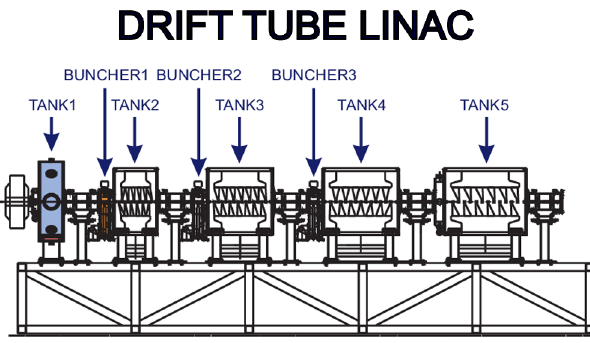
FIG. 2. The separated function ISAC-DTL. Quadrupole triplets along the lattice define the transverse optics. Courtesy of M. Marchetto, TRIUMF.